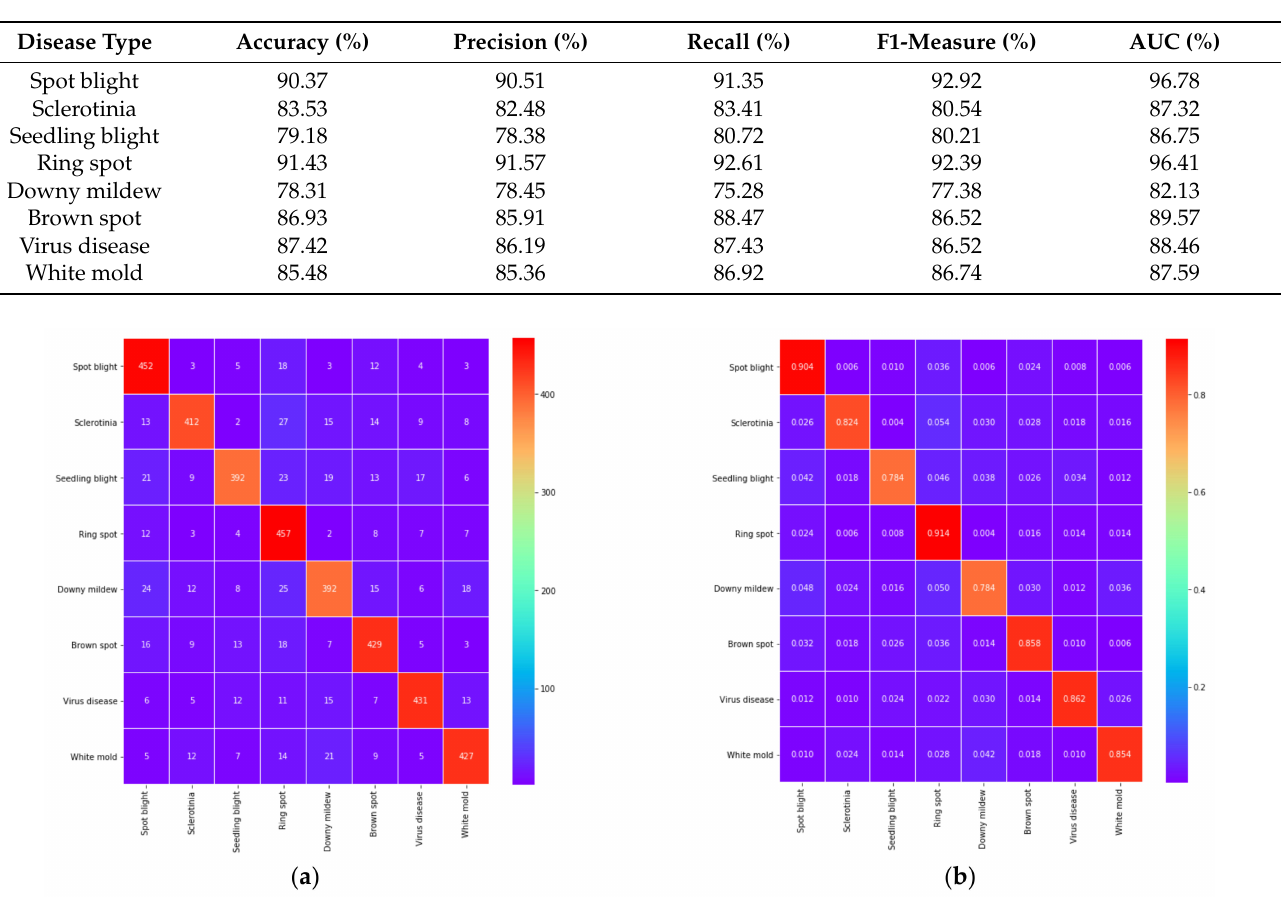
Table 5. Effect of different buckwheat diseases for their identification.